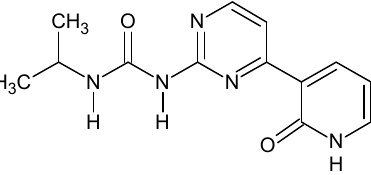
Figure 8. The structure of ureido- N -iso-propyl, N ’-4-(3-pyridin-2-on)pyrimidine. Ureido-N-iso-propyl,N’-4-(3-pyridin-2-on)pyrimidine (Figure 8) [52]. To the solution of 0.25 g of 1-[4-(2- methoxypyridin-3-yl)pyrimidin-2-yl]-3-propan-2-yl urea in anhydrous DCM (5 mL) at −20 °C, was slowly added a solution of 1.2 eq. of boron tribromide (0.26 g, 3 mL in anhydrous DCM). After one